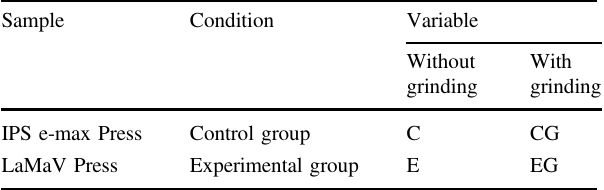
Table 1 Nomenclature adopted for the samples and conditions evaluated Sample Condition Variable